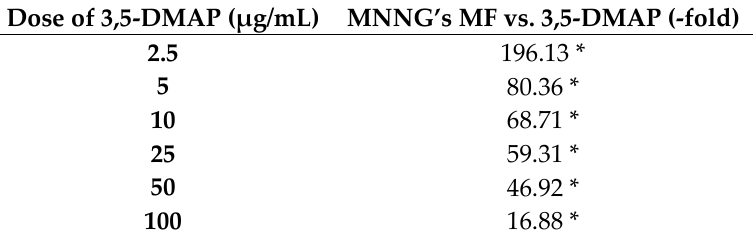
Figure 1. Ames test results for different doses of 3,5-DMAP. In none of the applied doses, 3,5-DMAP was found to be mutagenic. Table 1. The cell survival in 3,5-DMAP and MNNG applied cells in HPRT